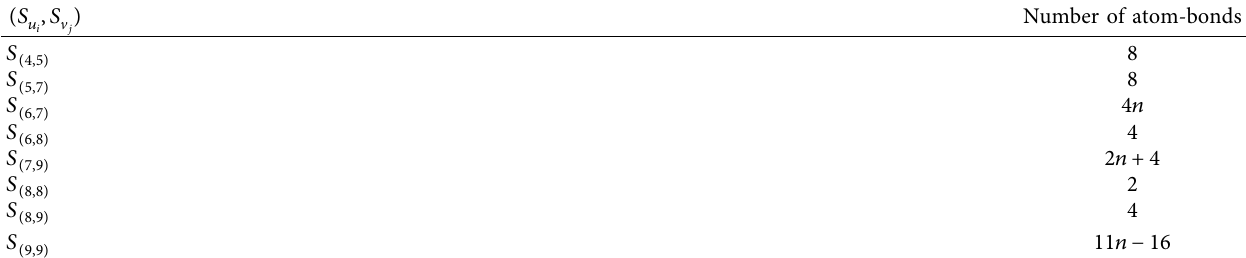
Table 2: Edge partition (sum of valency of the neighborhood